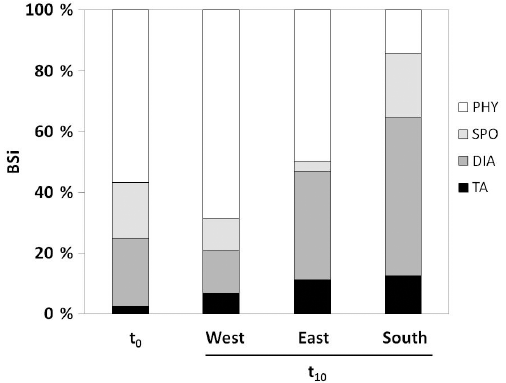
Figure 5. Proportions of phytoliths (PHY), sponge spicules (SPO), diatom frustules (DIA) and testate amoeba shells (TA) to total BSi in soils (upper 5cm) at Chicken Creek at t 0 and t 10 . Note that total BSi pools differ in size (see Fig.